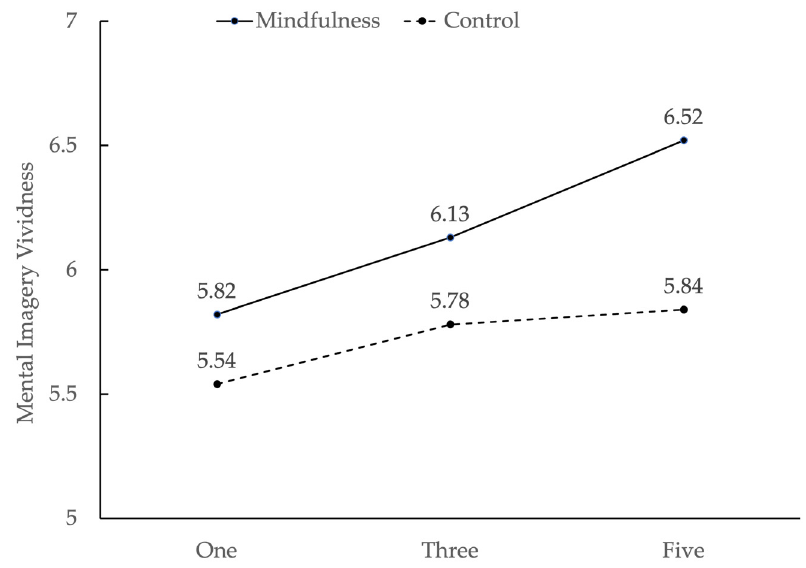
Figure 3. The interaction of mental imagery vividness between the number of sensory types and mindfulness in Study 3.